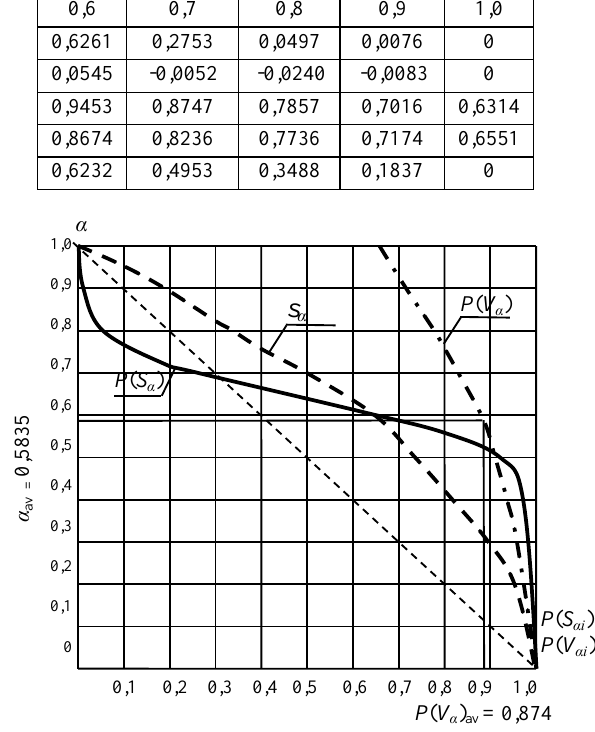
Table 1. Continuation